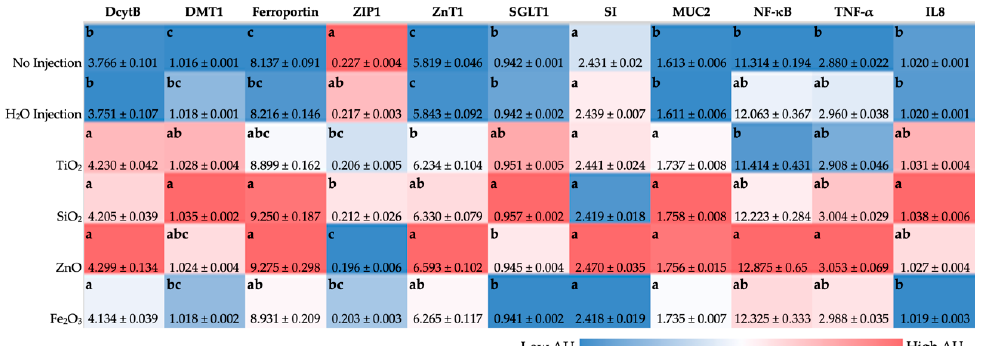
Figure 3. Effect of the intraamniotic administration of food-grade nanoparticles (NP) on duodenal gene expression of nutrient transporters, brush border membrane functional proteins, and pro-inflammatory cytokines. Gene expression has been normalized to the 18S housekeeping gene. Values are the means ± SEM, n = 6. Per gene (in the same column), blue depicts lower gene expression levels, and red depicts higher gene expression levels. a–c Per gene (in the same column), treatment groups not indicated by the same letter are significantly different according to one-way ANOVA with post hoc Duncan test ( p < 0.05). NI = non-injected. DcytB, Duodenal cytochrome b; DMT1, Divalent metal transporter 1; ZIP1, Zinc Transport Protein 1; ZnT1, Zinc transporter 1; SGLT1, Sodium-glucose